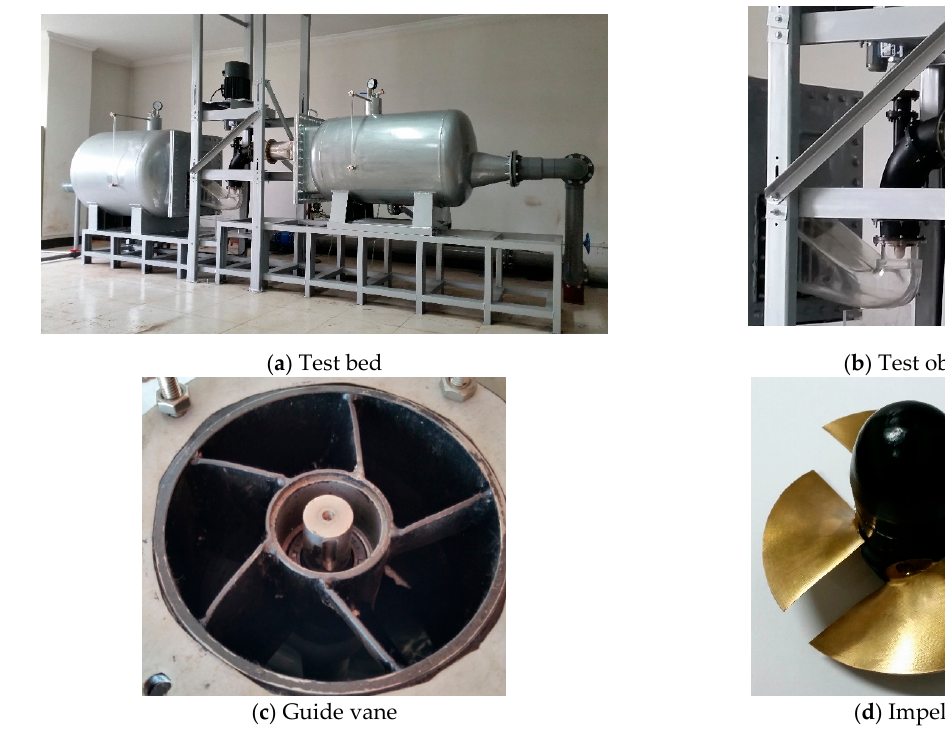
Figure 7. Physical model of test bed and pump device.